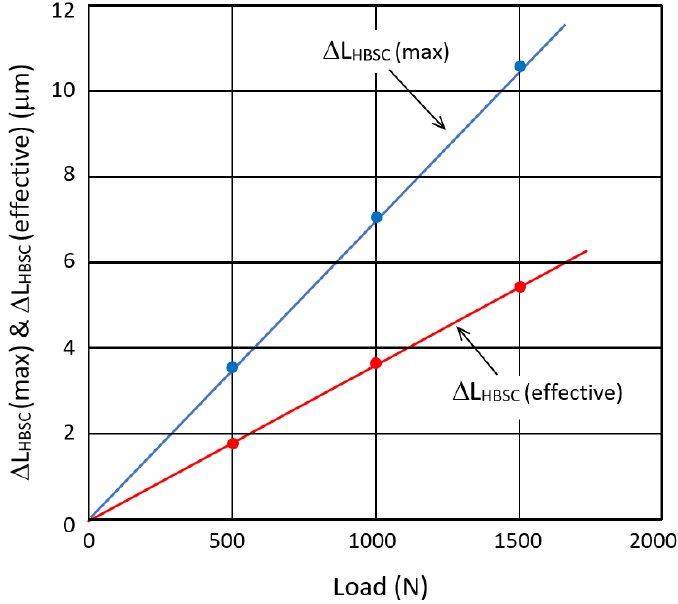
Figure 4. Maximum off-set deflection ∆ L HBSC (max) at the central point and effective off-set deflection ∆ L HBSC (effective) around the edge area displayed by the top face of the recess base as a function of applied axial load.